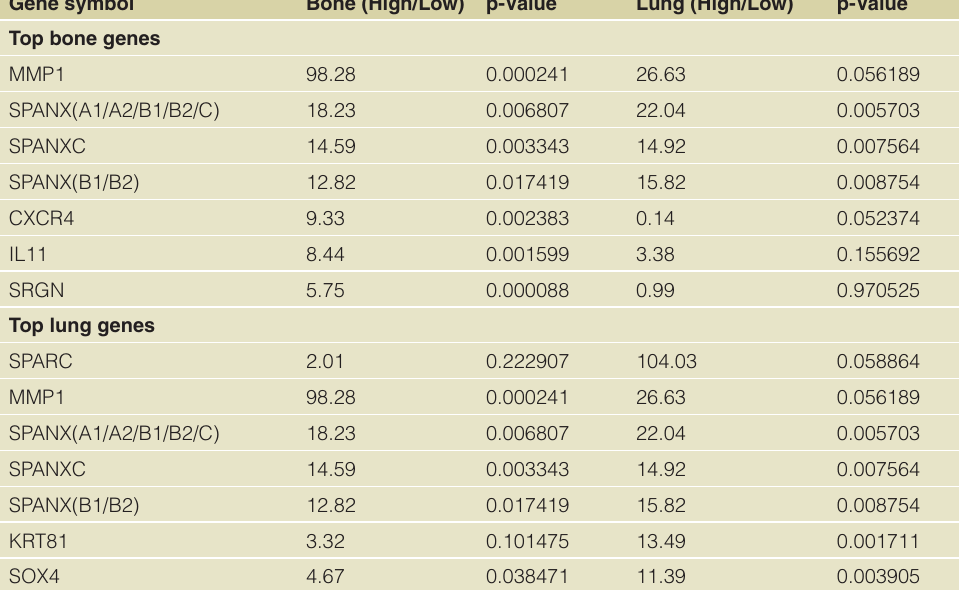
Table 6. The top five genes with greatest expression differential in genes of high metastatic potential and low metastatic potential in bone and lung. High bone metastatic cell lines are: 1833, Scp-2, Scp-25 and Scp-46. High lung metastatic cell lines are: 1834, 3481, 4142, 4173, 4175, 4180, Scp-3 and Scp-28. Low metastatic cells lines are: MDA-MB-231, Scp-6, Scp-21 and Scp-26. The gene expression values for these cell lines were used in a two-tailed t-test to calculate relative p-values. Genes with p-values over 0.06 were not